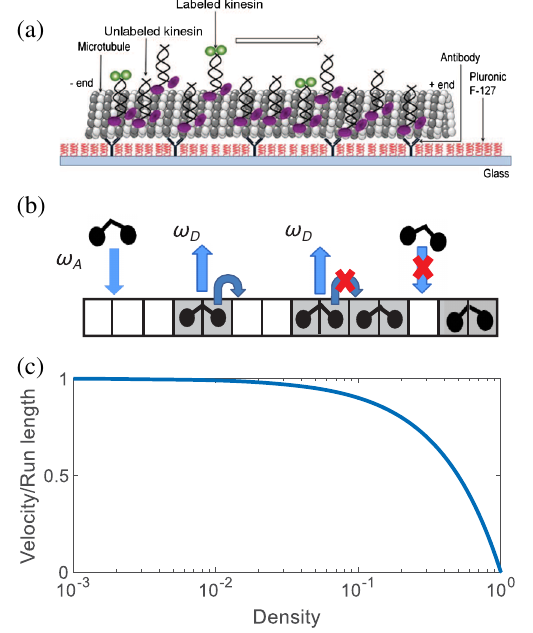
FIG. 1. Crowding of motor proteins along microtubules. (a) Schematic of the in vitro assay. Molecular motors walk along the microtubules attached to the glass slide. The fluorescently labeled motor proteins are excited and imaged using TIRF microscopy from below. (b) TASEP-LK model. The schematic illustrates the attachment, progression, and detachment of the FIG. 2. Correlation imaging measurements at high density. motors. Motors attach to unoccupied lattice sites with rate ω and A (a) Time series of fluorescently labeled OSM-3 motor proteins on detach from the lattice with rate ω . Each motor occupies two D a microtubule at a concentration of 40 nM in PEM12 buffer. The lattice sites (indicated by grey shaded area) and makes steps of plus and minus ends of the microtubule are indicated. (b) Sche- one lattice site. (c) Normalized velocity and run length as a matic of the correlation method used to determine the average function of density as predicted by the TASEP-LK model. motor velocity and run length. Fluorescent intensities are corre- lated in time and space along the microtubule. (c) Spatiotemporal map of correlation of the intensity of the complete image sequence (1000 images) shown in panel (a). Values of high correlation lie along a straight line, the slope of which represents the average velocity of the motors. (d) Cross sections of the correlation surface in panel (c) at delay times dt ¼ 0 . 1 s, 0.3 s, and 0.5 s. Gaussian fitting (dashed red line) is used to obtain the peak position and area under these curves. (e) Peak position as a function of time. The red linear fit yields the motor velocity. (f) Area under the curve as a function of time in the semilogarithmic representation. The red exponential fit yields the detachment rate of